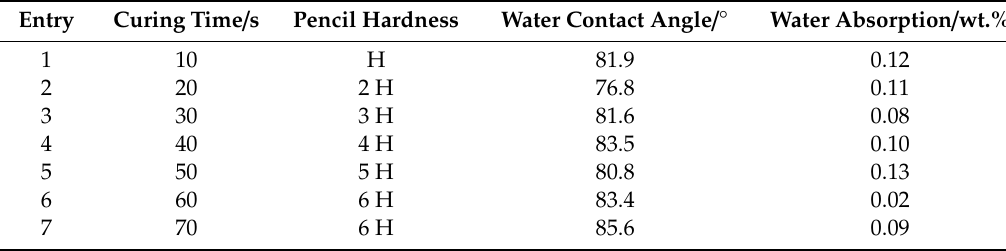
Table 1. E ff ect of UV-curing